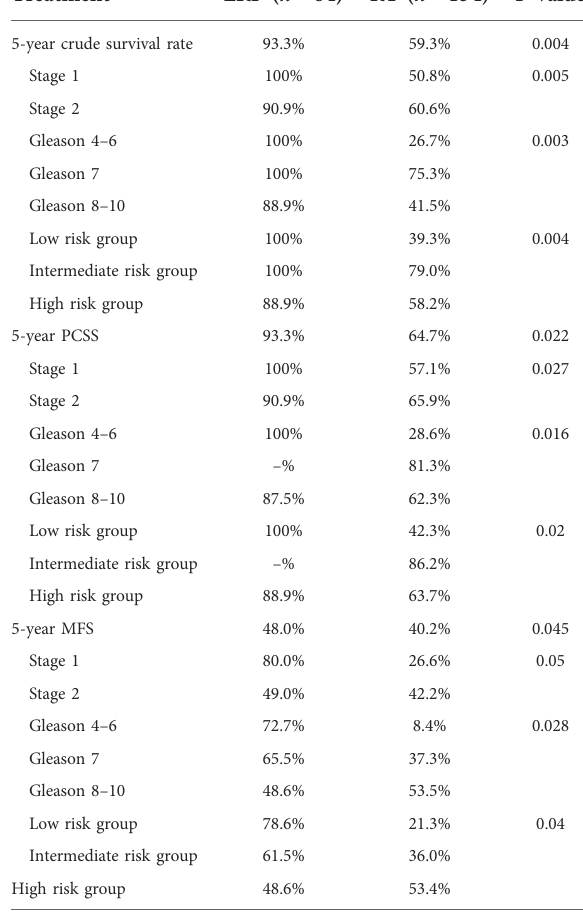
TABLE 2 Five-year crude survival rate, prostate cancer-speci fi c survival, and metastasis-free survival according to treatment